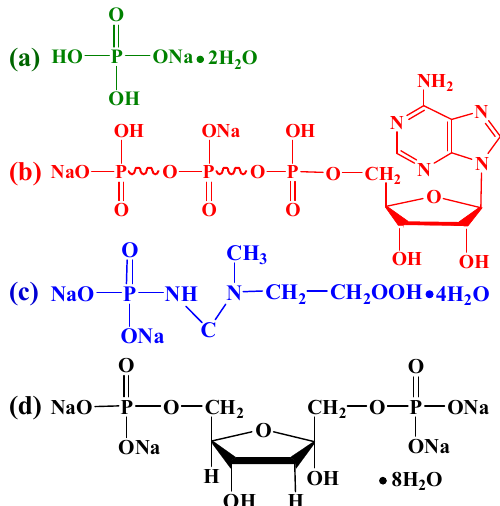
Figure 1. Chemical structures of the phosphate salt and biocompatible phosphorus-containing biomolecules used in this study: ( a ) sodium dihydrogen phosphate dihydrate (NaH 2 PO 4 · 2H 2 O); ( b ) adenosine 5 ′‐ triphosphate disodium salt (ATP); ( c ) creatine phosphate disodium salt tetrahydrate (CP); ( d ) D-fructose 1,6-bisphosphate trisodium salt octahydrate (FBP).